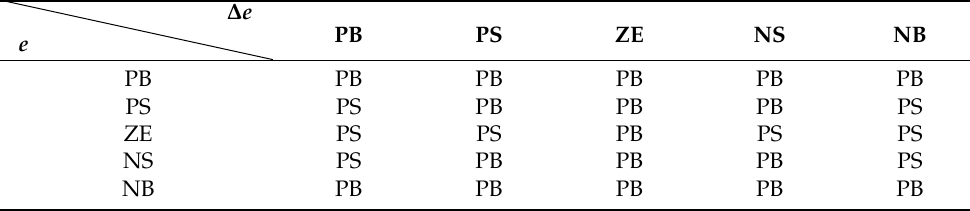
Table 2. Fuzzy rules of K P